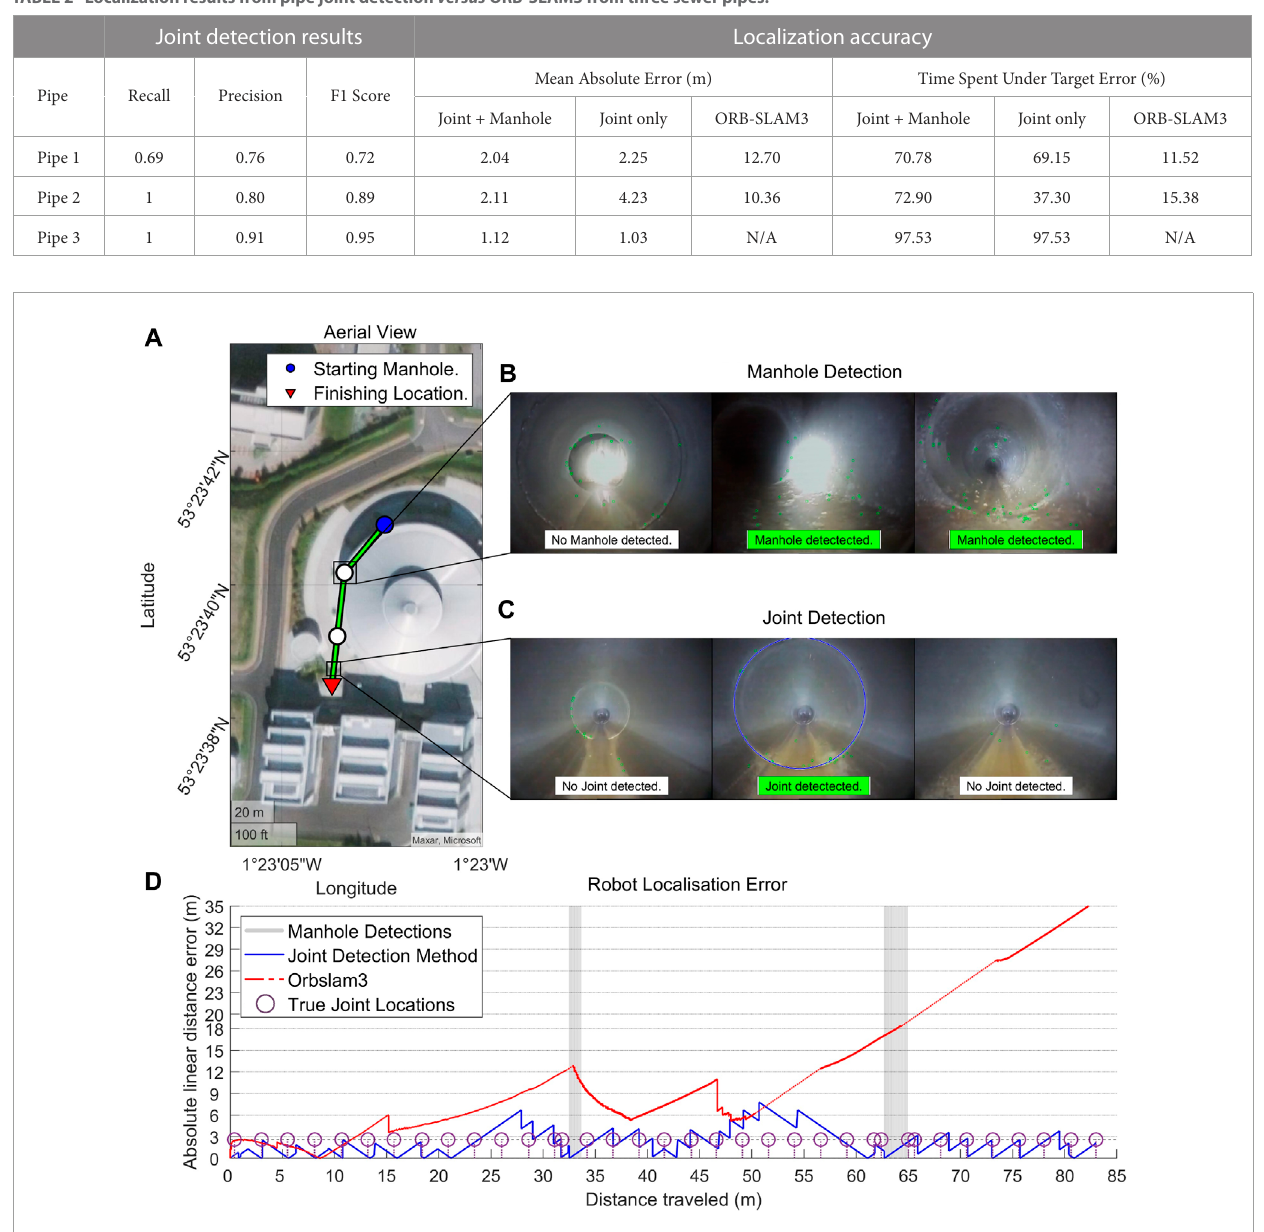
FIGURE 9 Localization results in Pipe 1. (A) Aerial view of pipe 1 with manhole locations highlighted as circles. (B) Example in-pipe view of a manhole, with successful manhole detection highlighted in green. (C) Example in-pipe view of a pipe joint, with successful joint detection highlighted in green. (D) Comparison of errors in localization using the method of joint detection with manhole correction versus ORB-SLAM3, with loss of tracking in ORB-SLAM3 denoted as a dashed red